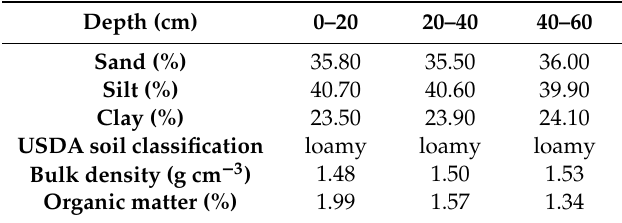
Table 1. Physical soil properties at three